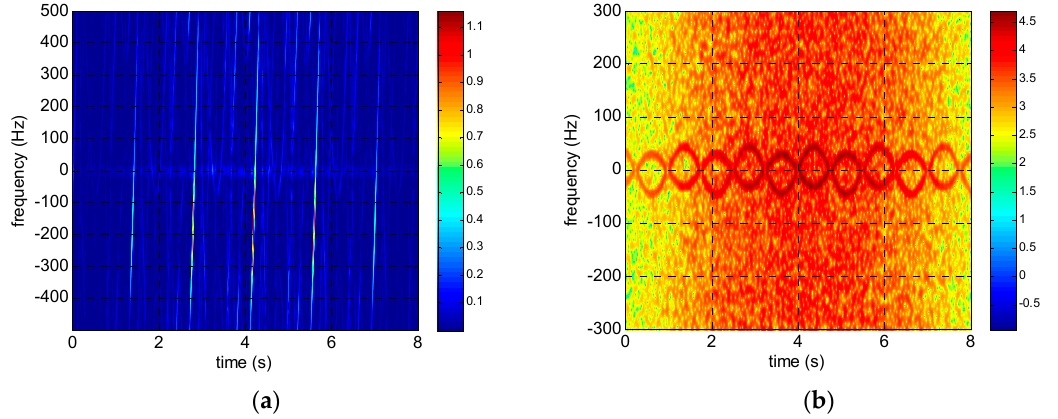
Figure 6. Time–frequency distributions of corner reflectors rotating at 20 r/min ( a ) before and ( b ) after intra ‐ pulse interference processing.